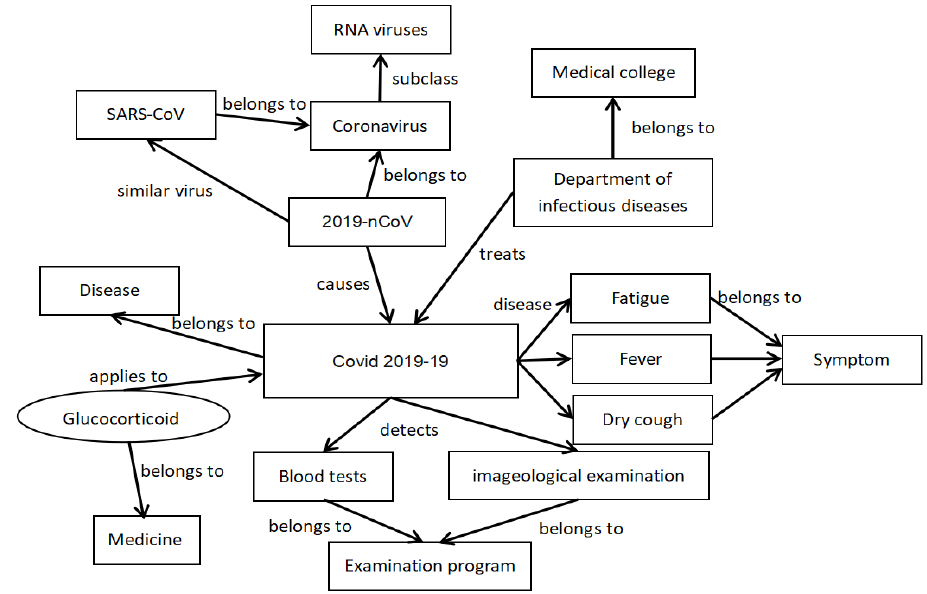
Figure 1. An Example of Medical Ontology On COVID-19.